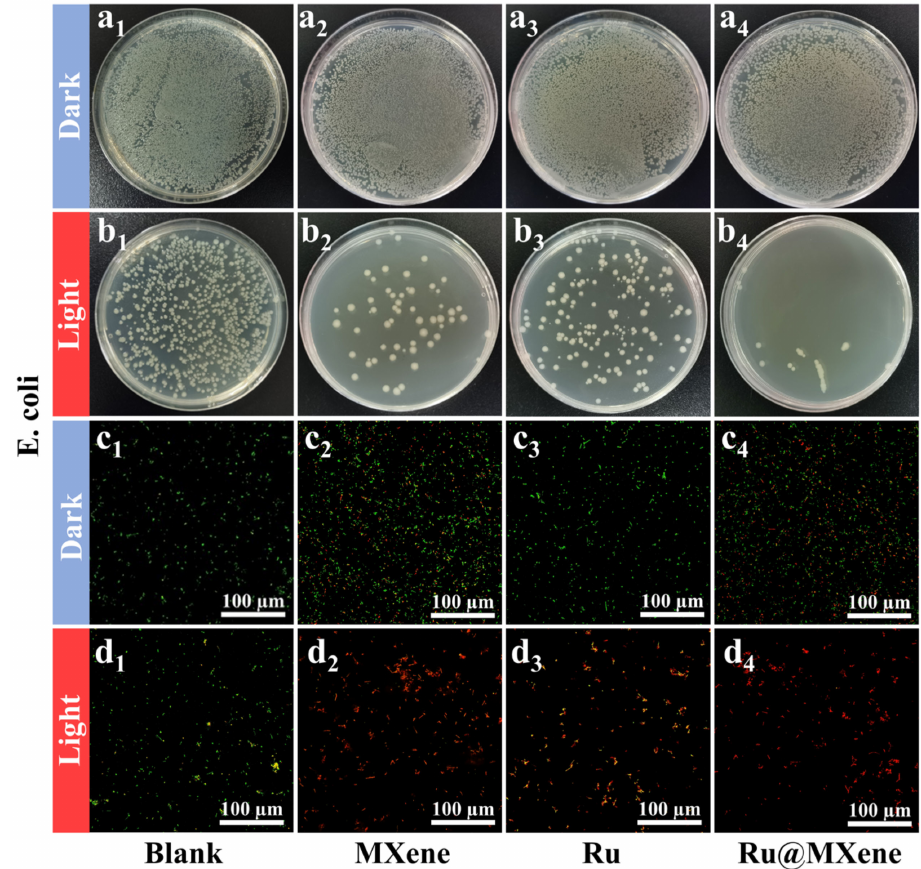
Figure 7. Antibacterial activities: bacterial suspensions without any material were used as control ( a 1 – d 1 ). Spread plate results of E. coli treated with MXene ( a 2 , b 2 ), Ru ( a 3 , b 3 ) and Ru@MXene ( a 4 , b 4 ) after exposure in the dark or illumination with xenon lamp (150 mW/cm 2 , 30 min). Corresponding confocal images of live/dead fluorescence of E. coli on MXene ( c 2 , d 2 ), Ru ( c 3 , d 3 ) and Ru@MXene ( c 4 , d 4 ) with or without xenon lamp (150 mW/cm 2 , 30 min). (Sample concentration: 110 µ g/mL for Ru@MXene, 15 µ m for Ru, and 100 µ g/mL for MXene. The concentrations of Ru and MXene are consistent with the ratio in